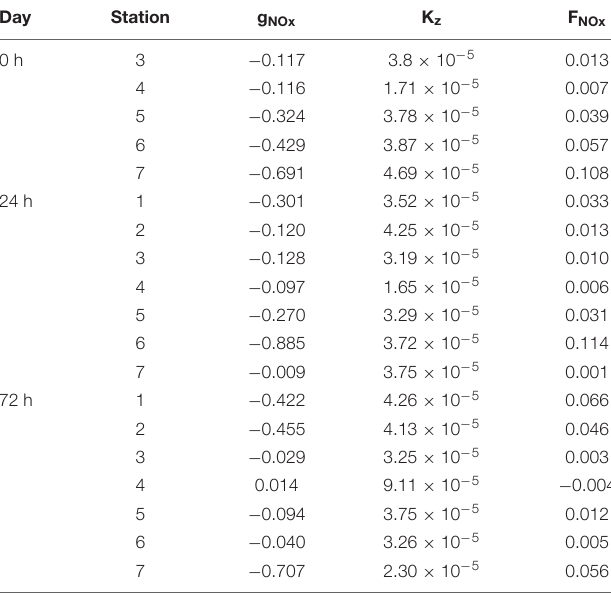
TABLE 1 | Values of nutrient gradients (g NOx ; mmol · m − 3 ), vertical eddy diffusivity